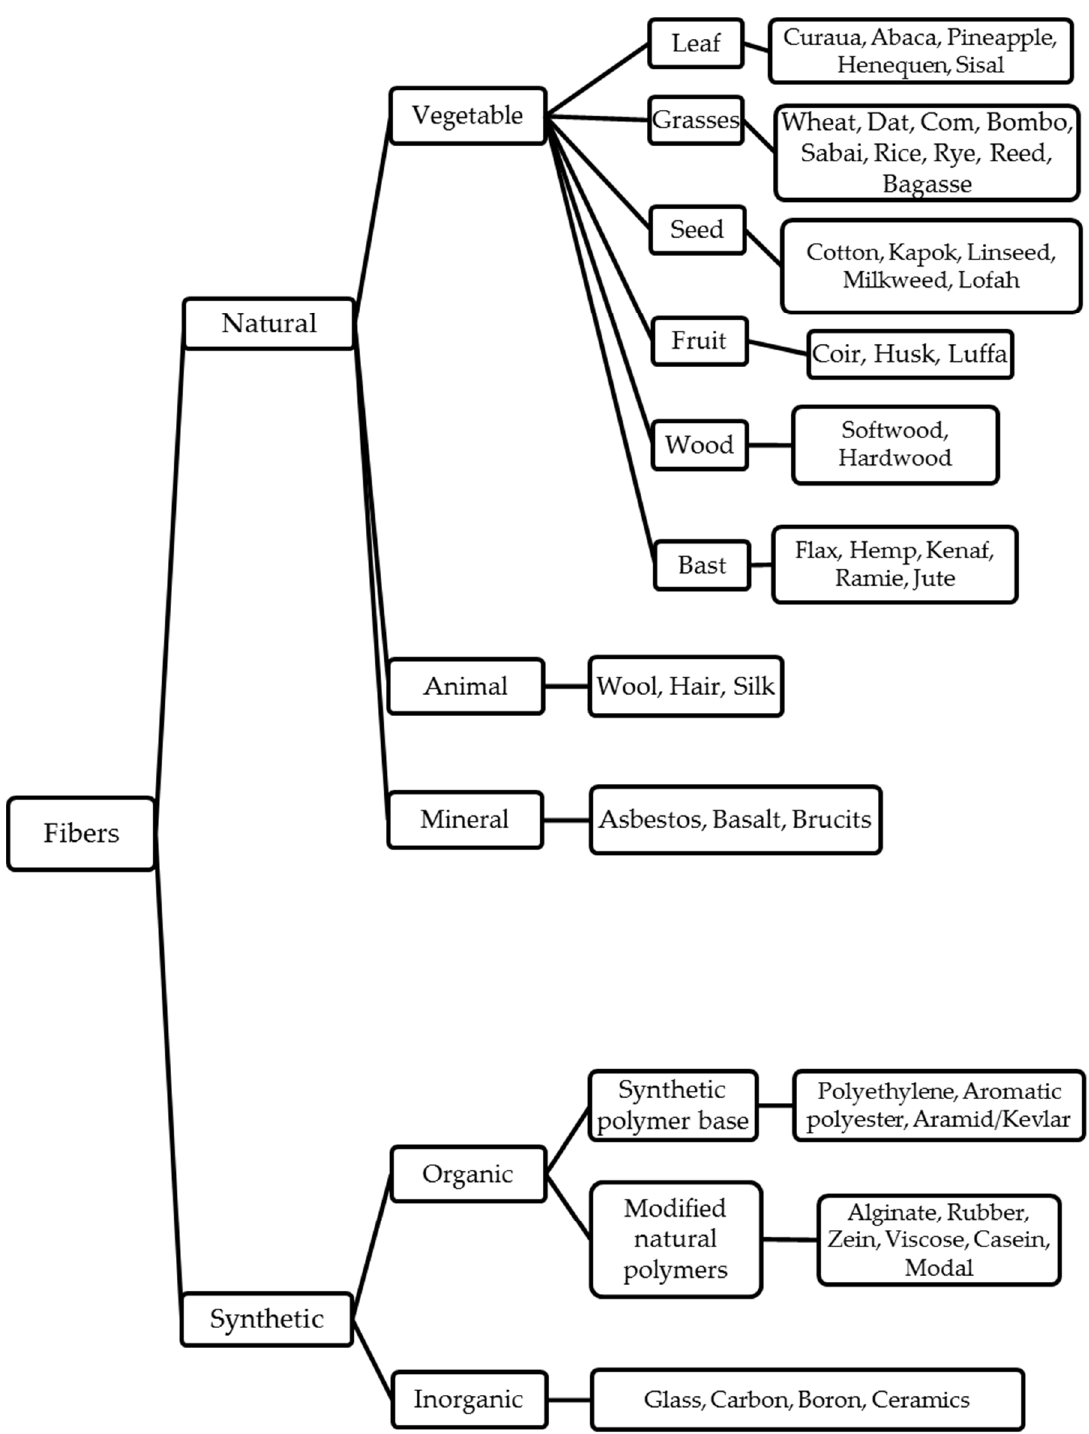
Figure 4. Classification of natural and synthetic fibers. Adapted from